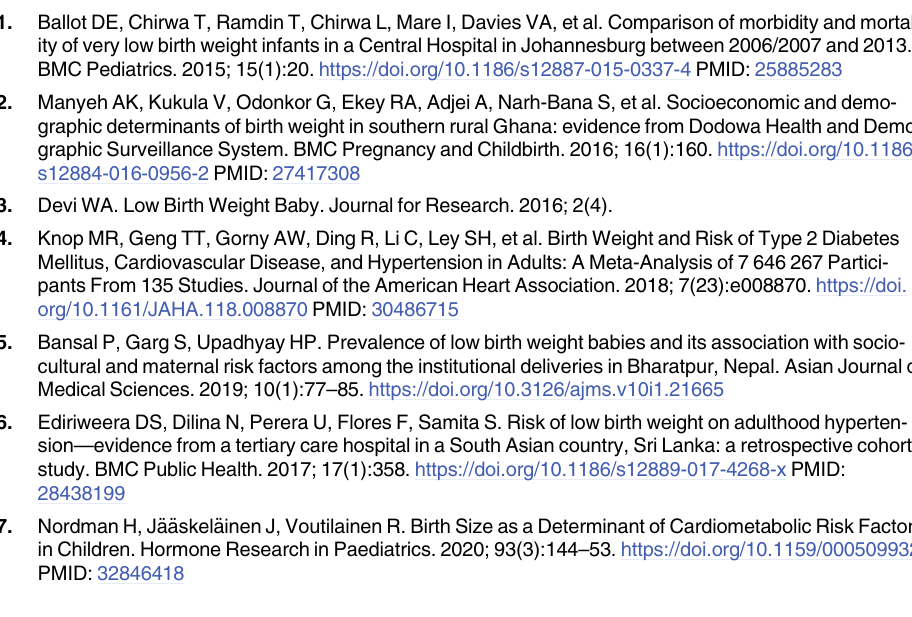
S1 Table. Distribution of the risk factors by wealth index using BDHS, 2017–18.